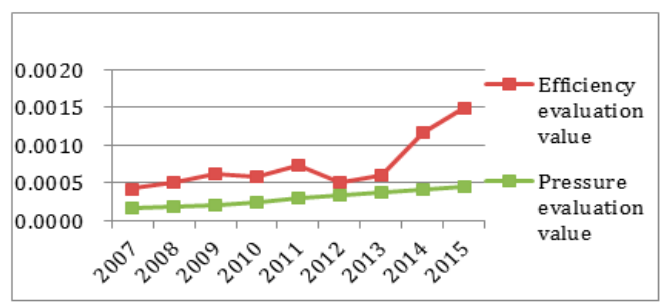
Figure 10. Evaluation value change in the social subsystem.